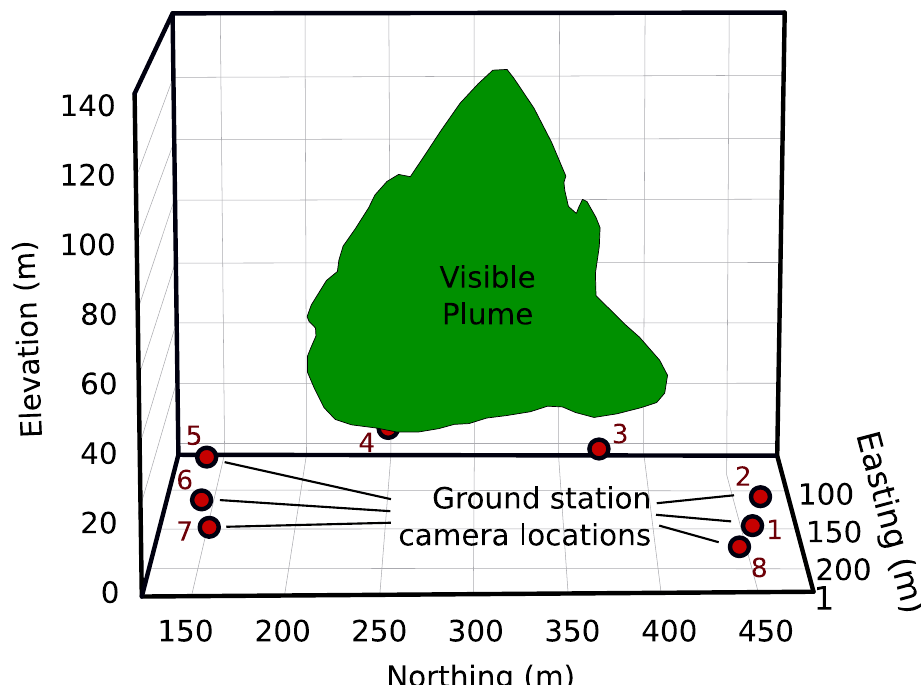
Figure 5. Measurement methods at the cooling tower site with the bounding plume with red dots representing the ground cameras.